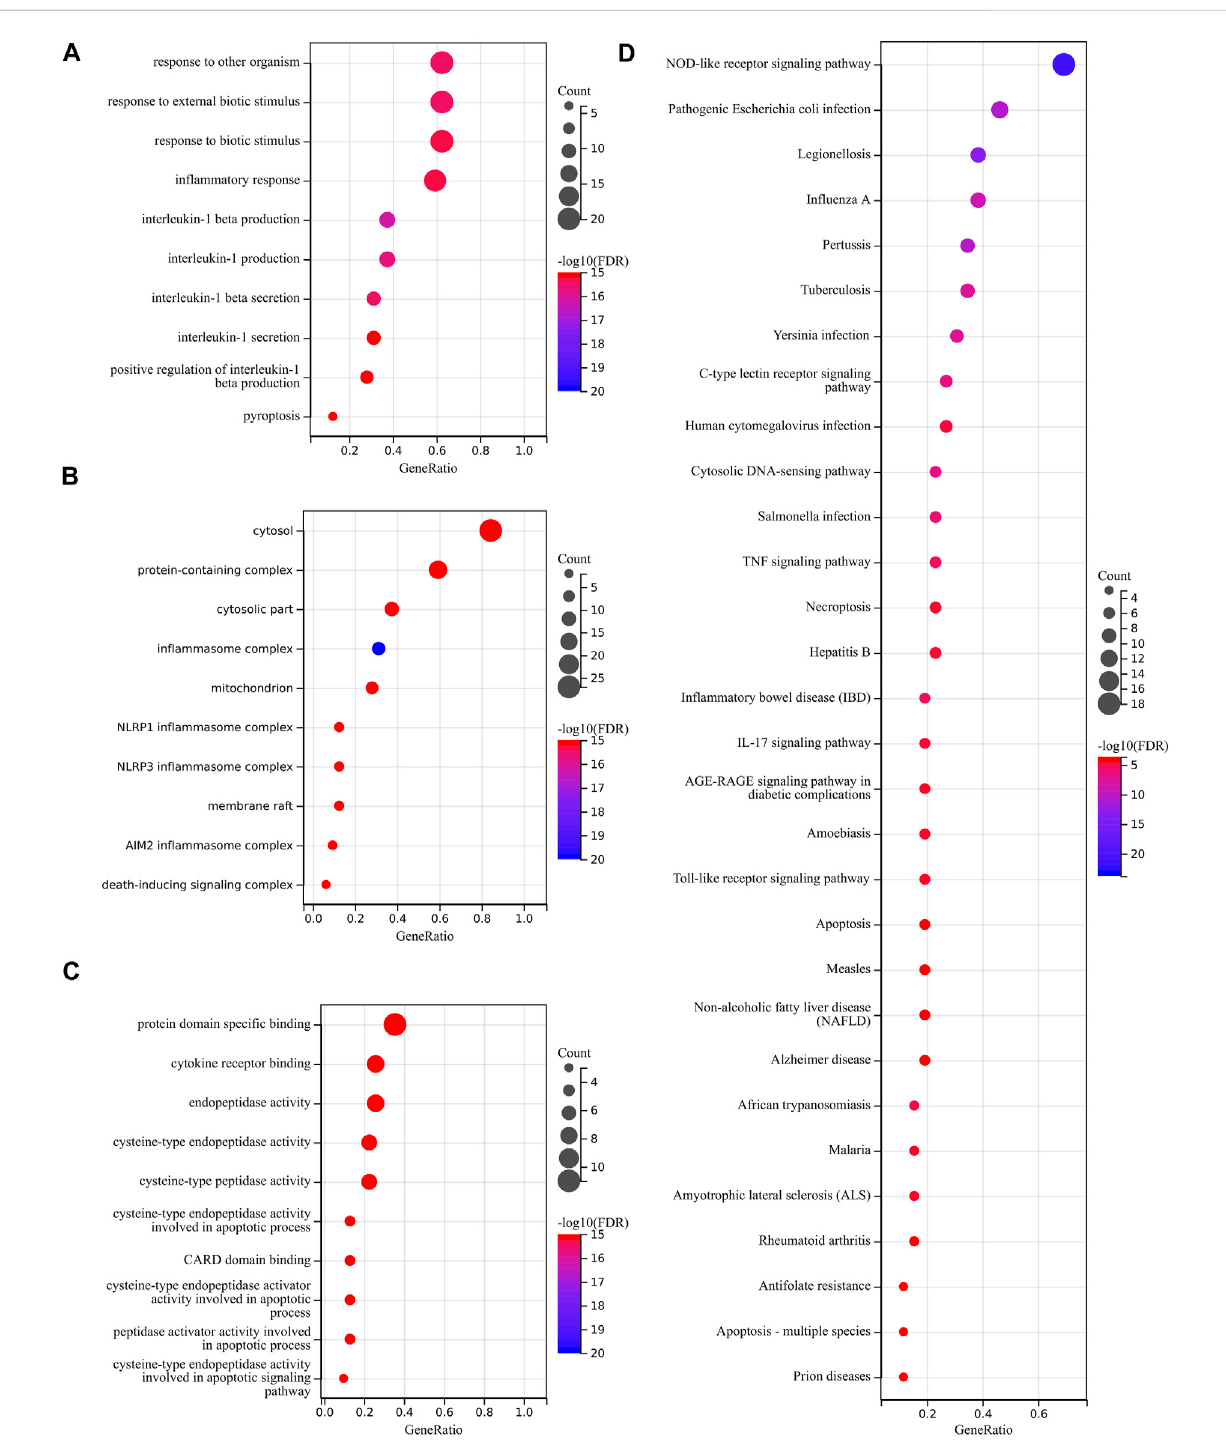
FIGURE 3 Functional enrichment analysis of PRGs. (A – C) The enriched item in gene ontology analysis. (D) The enriched item in Kyoto Encyclopedia of Genes and Genomes